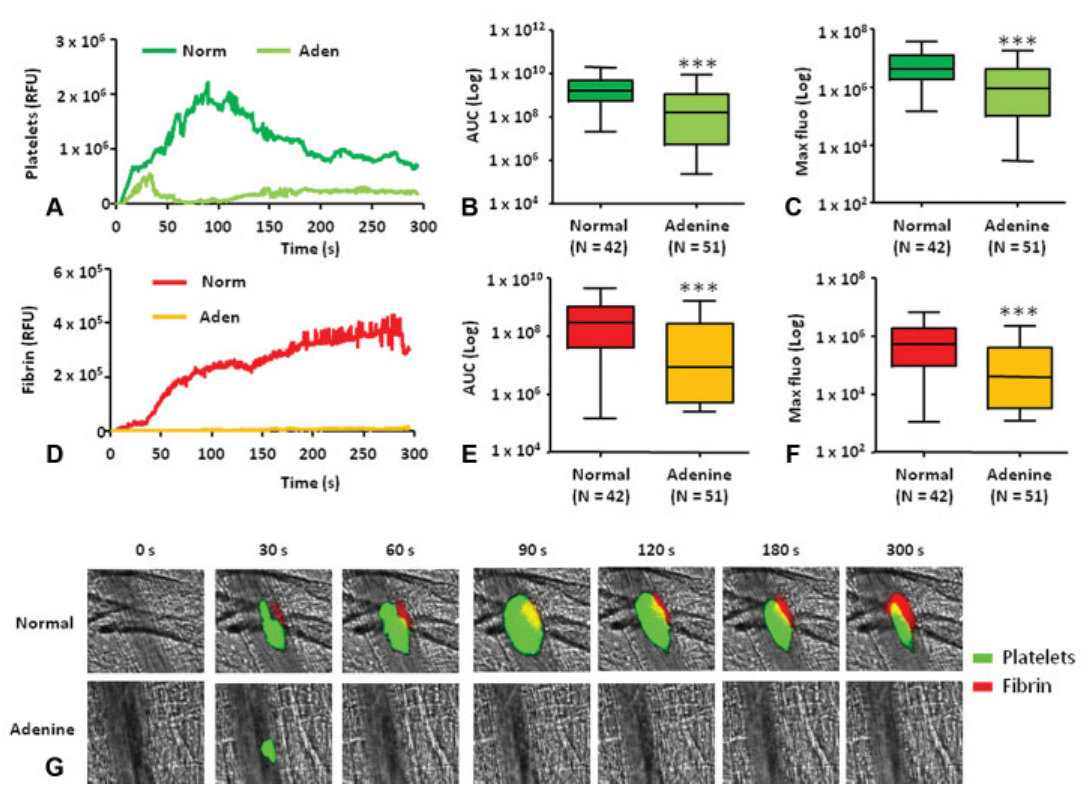
Fig.5 Thrombus formation following laser-induced injury is affected in the CKD model of micefed with adenine. Kinetics of thrombus formation was assessed for 300seconds after the initial injury of cremaster arterioles and median-integrated fl uorescent intensities of normal-diet mice (dark green/red) and adenine-diet mice (light green/orange) after infusion of ( A ) anti-GPIb α (platelets) and ( D ) anti fi brin ( fi brin) are plotted over time. Data usingeither the maximum fl uorescence ( B and E ) or AUC ( C and F ) are shown andare expressedasboxplotsof the indicated number of thrombi (N) obtained in three normal mice and four adenine mice. ( G ) Representative images of intravital microscopy are shown for each condition. (cid:4)(cid:4)(cid:4) p < 0.001. Aden, adenine; anti-GPIb α ; anti-glycoprotein Ib alpha; AUC, area under the curve; CKD, chronic kidney disease; Norm, normal; RFU, relative fl uorescence units. Scale bar ¼ 10 μ m. ( ► Fig. 5D and G ). Evaluation of the total platelet accumula- tion and fi brin generation by measuring the area under the curve (AUC) resulted in signi fi cant reduction in comparison to control ( ► Fig. 5B and E ). Similarly, the maximal platelet